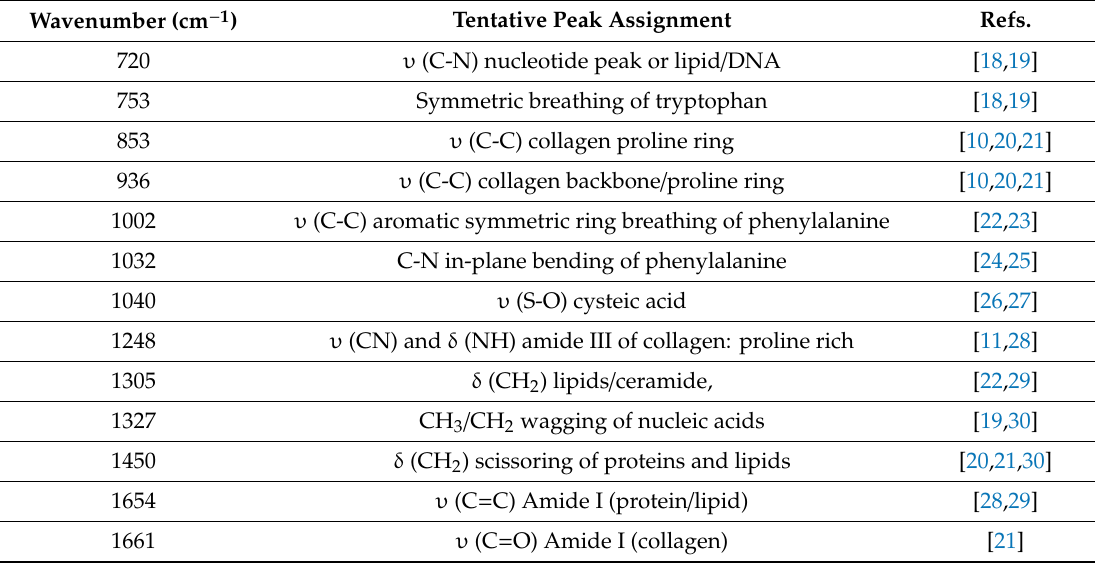
Table 1. Tentative peak assignments for human skin tissue Raman spectra. Greek letters denote the type of vibrational mode ( υ , stretching; δ ,